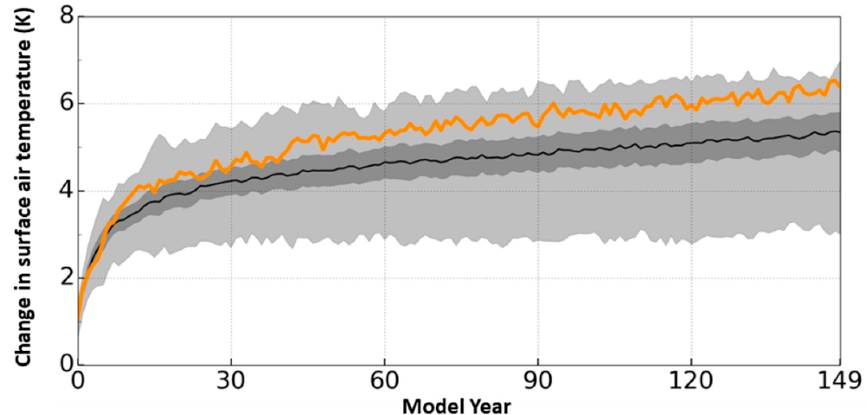
Figure 1. Time series of global mean surface air temperature change (K) in the abrupt experiment. The light gray shaded area indicates the range of CMIP5 models and dark gray shading area indicates 5–95% confidence range of CMIP5 models. Orange and black lines show K-ACE and CMIP5 ensemble mean, respectively.